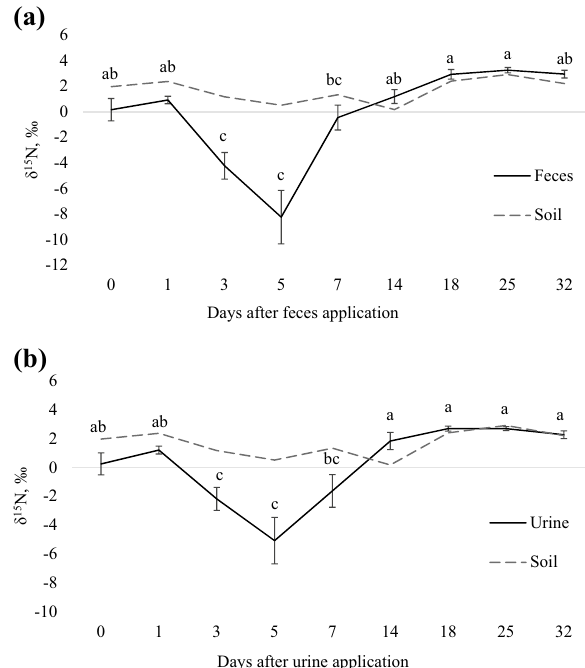
Figure 2. δ 15 N isotopic composition of N 2 O emitted by ( a ) feces from beef steers fed sericea lespedeza [SL; Lespedeza cuneata (Dum. Cours.) G. Don], where values represent the average of three diets (0, 50 or 100% SL) in two experimental periods, and means followed by different letters are significantly different among sampling days ( P day < 0.001); and ( b ) urine patch of beef steers fed 0SL, 50SL or 100SL, where asterisk indicates differences among diets within day ( P SL*Day < 0.001). Bars refer to standard deviation. Dashed line represents soil (no excreta)